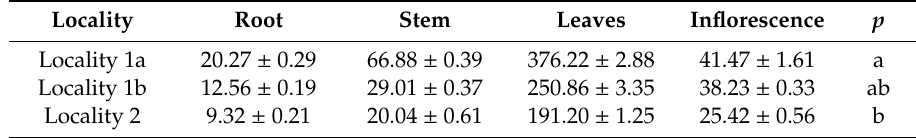
Table 2. Flavonoid content in the di ff erent parts of I. helenium (mg of rutin (Ru) / g). Locality Root Stem Leaves